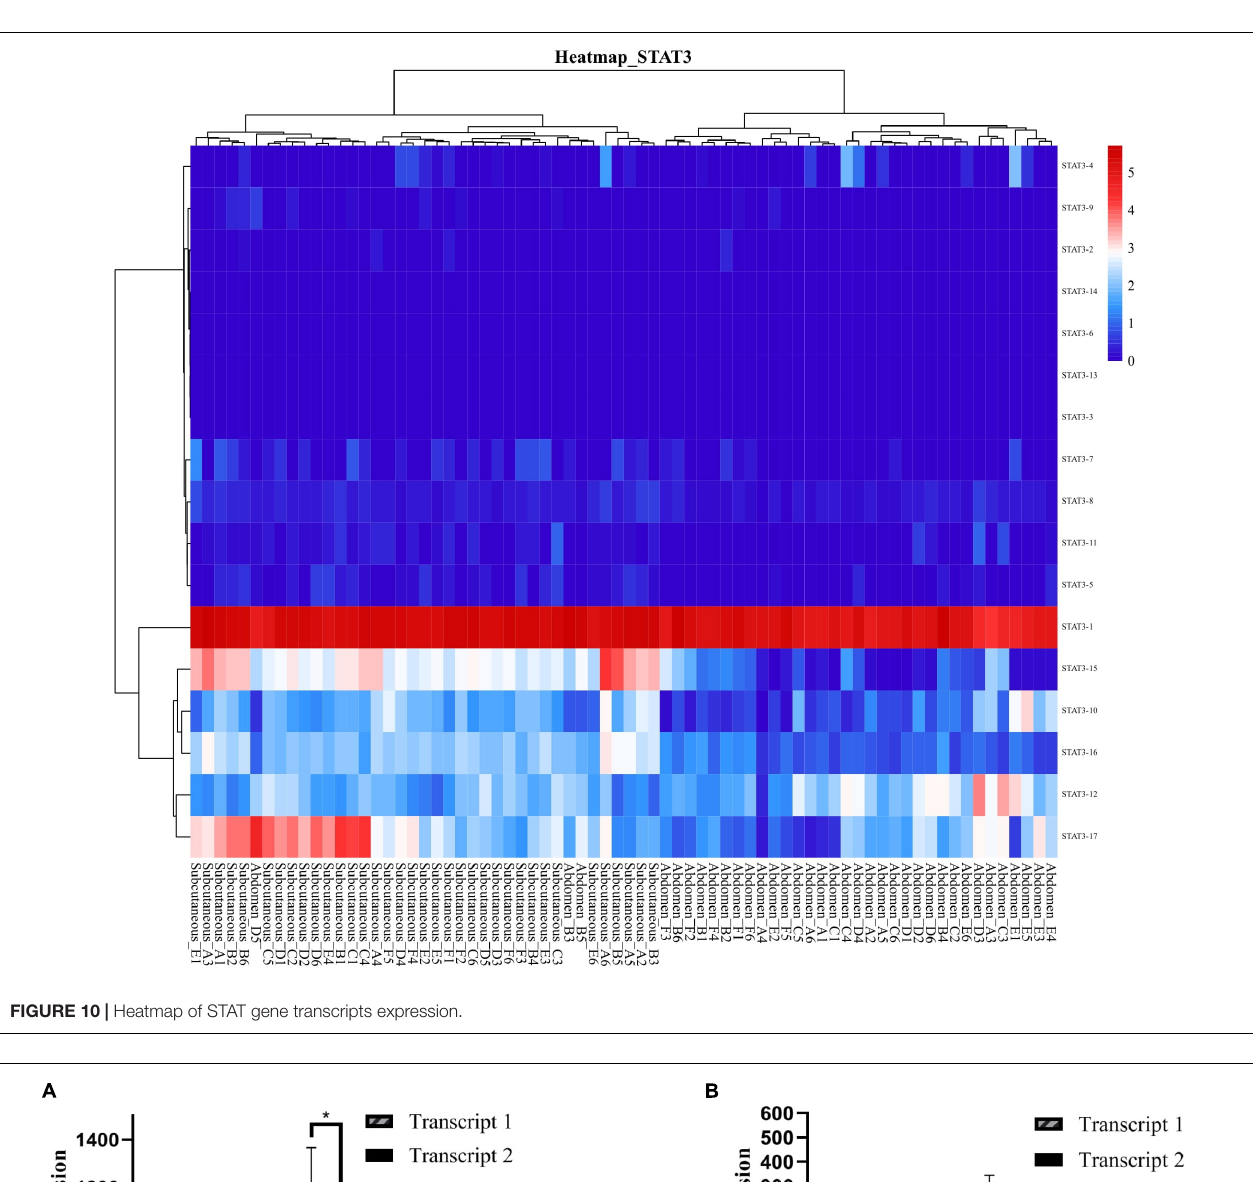
FIGURE 10 | Heatmap of STAT gene transcripts expression.